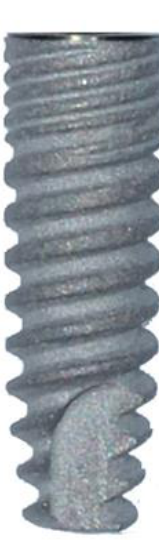
Figure 1. Dental titanium implants: new ( A ) and removed in the patients with full-blown peri-implantitis after 8 years ( B ) and 25 years ( C ).